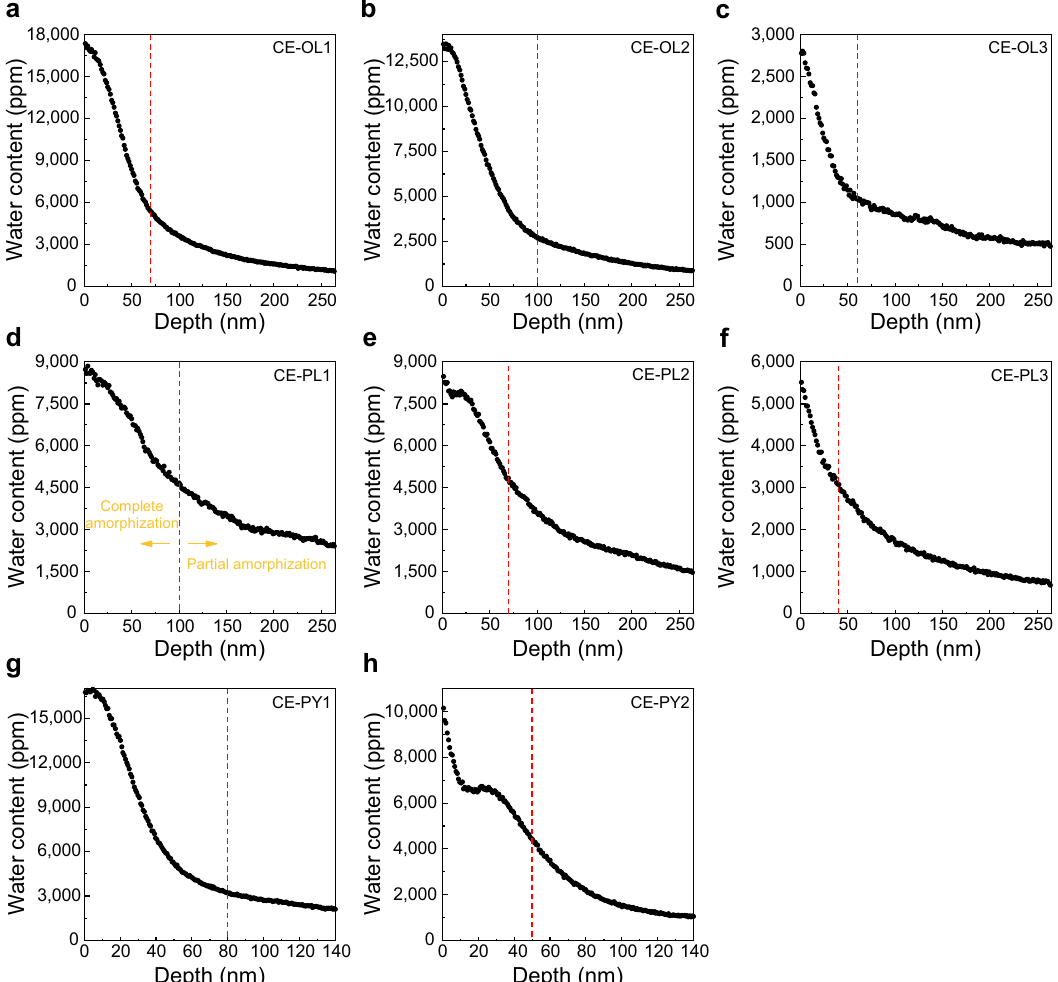
Fig. 3| Depthdistributioncharacteristicsofwaterinlunarminerals. a – c Depth pro fi les of water content in olivine samples a CE-OL1, b CE-OL2, and c CE-OL3. d – f Depth pro fi les of water content in plagioclase samples d CE-PL1, e CE-PL2, and f CE-PL3. g , h Depth pro fi les of water content in pyroxene samples g CE-PY1 and h CE-PY2.ThedepthsoftheNanoSIMSmeasurementswereobtainedusingthethin